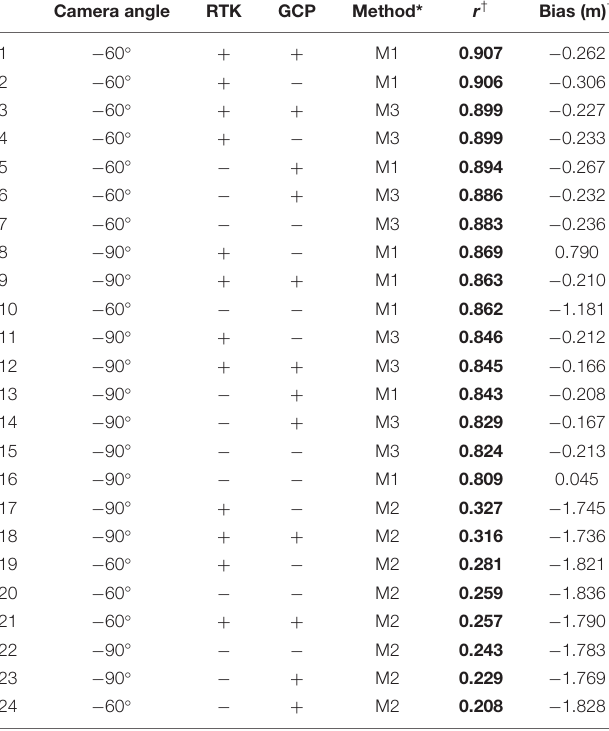
TABLE 5 | Correlation analysis between PH measured and PH SfM in the vegetative stage of Field 2. Camera angle RTK GCP